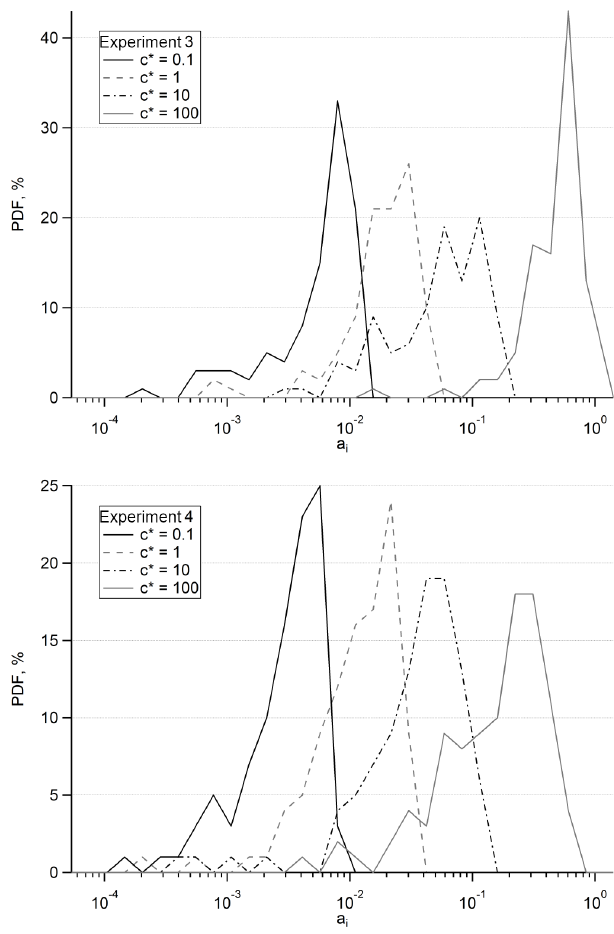
Figure 6. Probability density functions (PDFs) of α i s for volatil- = 0.01, 0.1, 1, 10 and 100µgm − 3 ) for one high RH ity bins ( C ∗ i (exp. 3, upper panel) experiment and one low RH (exp. 4, lower